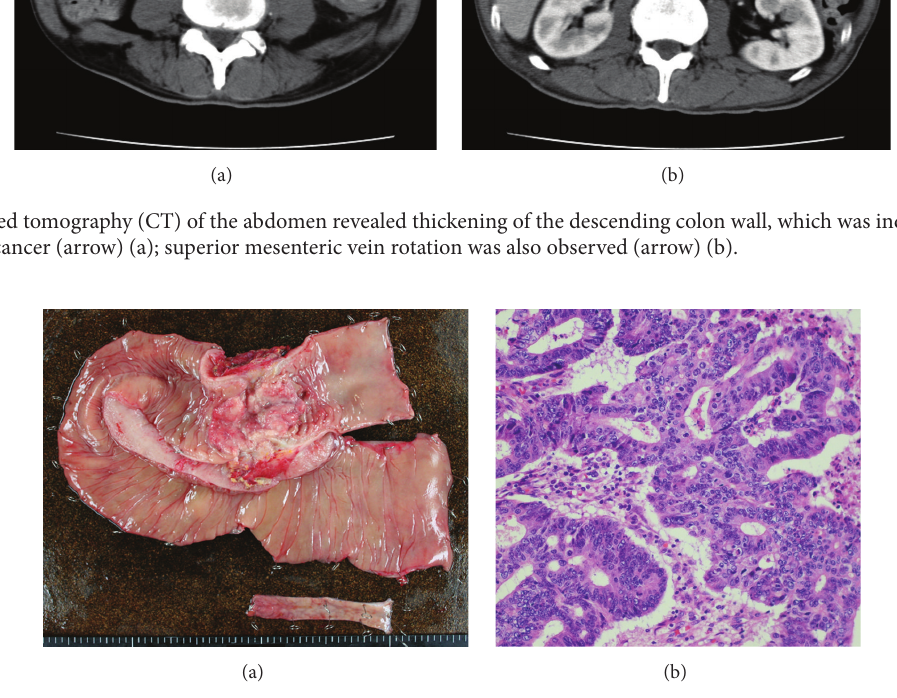
Figure 4: An operative specimen revealed advanced descending colon cancer with direct invasion of the transverse colon (a). A histopathological examination with hematoxylin and eosin staining confirmed that the lesion was moderately differentiated tubular adenocarcinoma